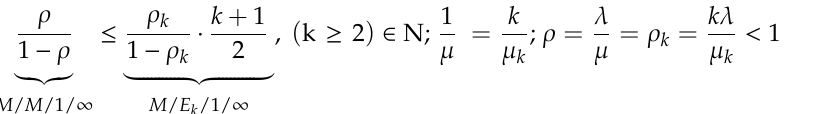
Figure 2. Inventory management queueing system for recent solutions M/E k / r.